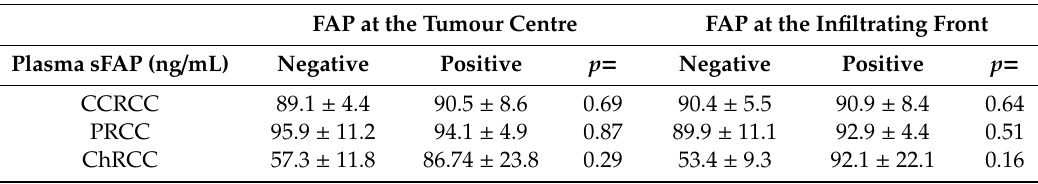
Figure 1. Immunohistochemical fibroblast activation protein- α (FAP) staining in renal tumours and plasma levels of soluble FAP (sFAP) in renal tumour patients and control subjects. ( A ) Upper row shows haematoxylin-eosin staining of renal tumours. Middle and lower rows show FAP immunostaining at the tumour centre and border, respectively. Original magnification, × 250. ( B ) Renal cell carcinomas (RCCs) expressed FAP, whereas renal oncocytoma (RO) was negative. Staining was scored as negative or positive. Chi-square test was performed for comparisons in tumour tissues. ( C ) Soluble FAP (sFAP) was significantly lower in plasma samples from CCRCC and ChRCC patients than in controls. A Mann–Whitney U-test was used for comparisons in plasma samples. Table 1. Plasma soluble FAP (sFAP) levels in RCC patients depending on FAP expression in tumour tissues. Data were analysed by Mann-Whitney